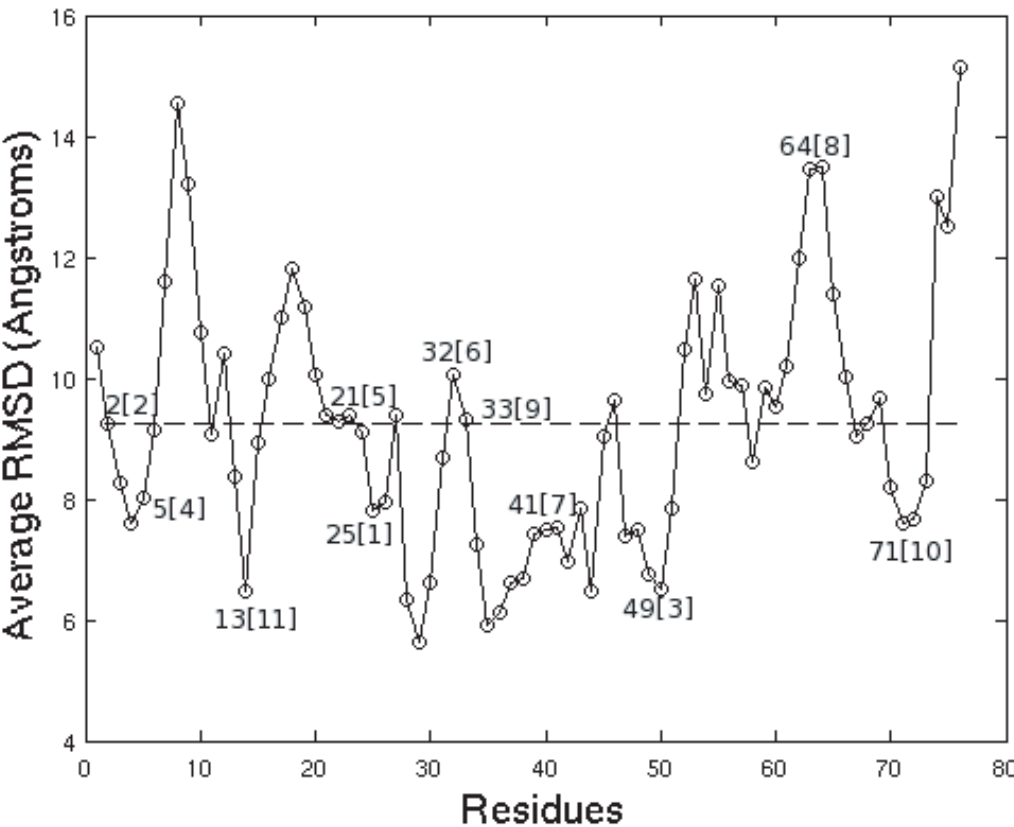
Figure 10. Position of HPZ residues as a function of the average RMSD of the residues. The top 11 HPZ residues are marked with 7/11 of the top HPZ residues lying near the troughs in the plot, indicating their greater stability with respect to the non-HPZ residues.